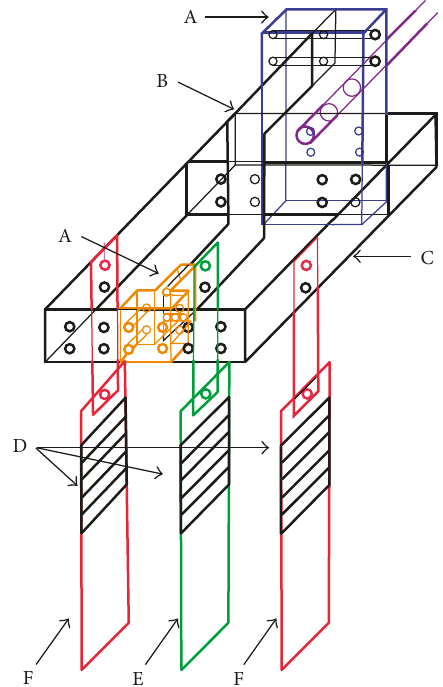
Figure 1: Diagram of the circuit used for tests: (A) polyethylene structural elements, (B) copper busbar of the electrode, (C) copper busbar of two electrodes, (D) PTFE insulation, (E) cathode elec- trochemical reduction variant, anode electropolishing variant, and (F) anode electrochemical reduction variant, cathodes electro- polishing